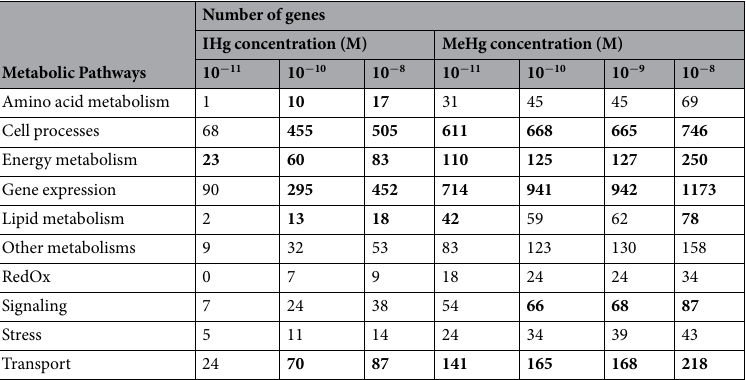
Table 1. Number of significantly dysregulated genes in metabolic pathways (MapMan) in C. reinhardtii after 2 h exposure to increasing concentrations of IHg and MeHg (numbers in bold show categories with high dysregulation according to Wilcoxon test, p <